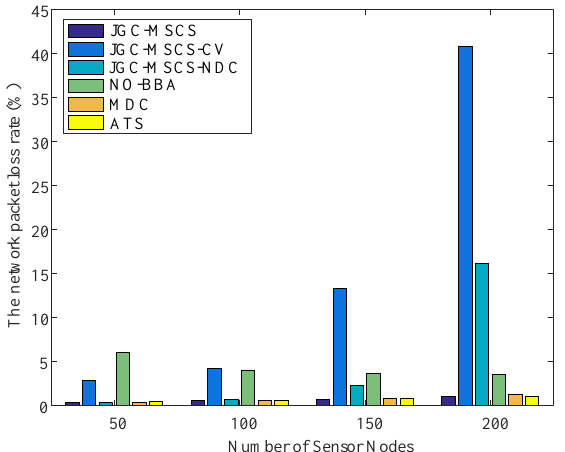
Figure 12. Comparison of the network packet loss rate under different network densities of the proposed JGC-MSCS with the JGC-MSCS-CV, JGC-MSCS-NDC, NO-BBA, and MDC methods respectively.